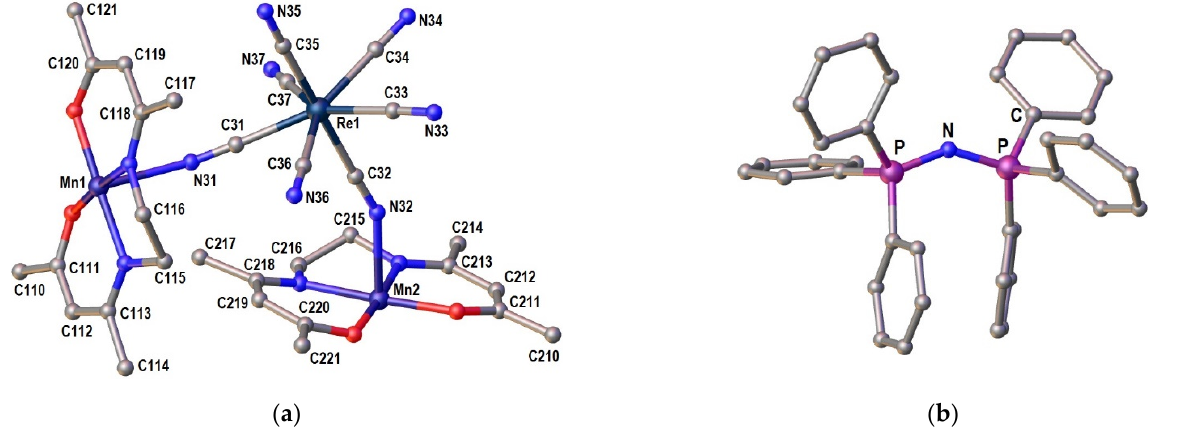
Figure 1. ( a ) Independent part, [{Mn(acacen)] 2 [Re(CN) 7 ] − , of the anionic layer of 2 with the atom numbering scheme of the unique atoms; ( b ). Hydrogens atoms are